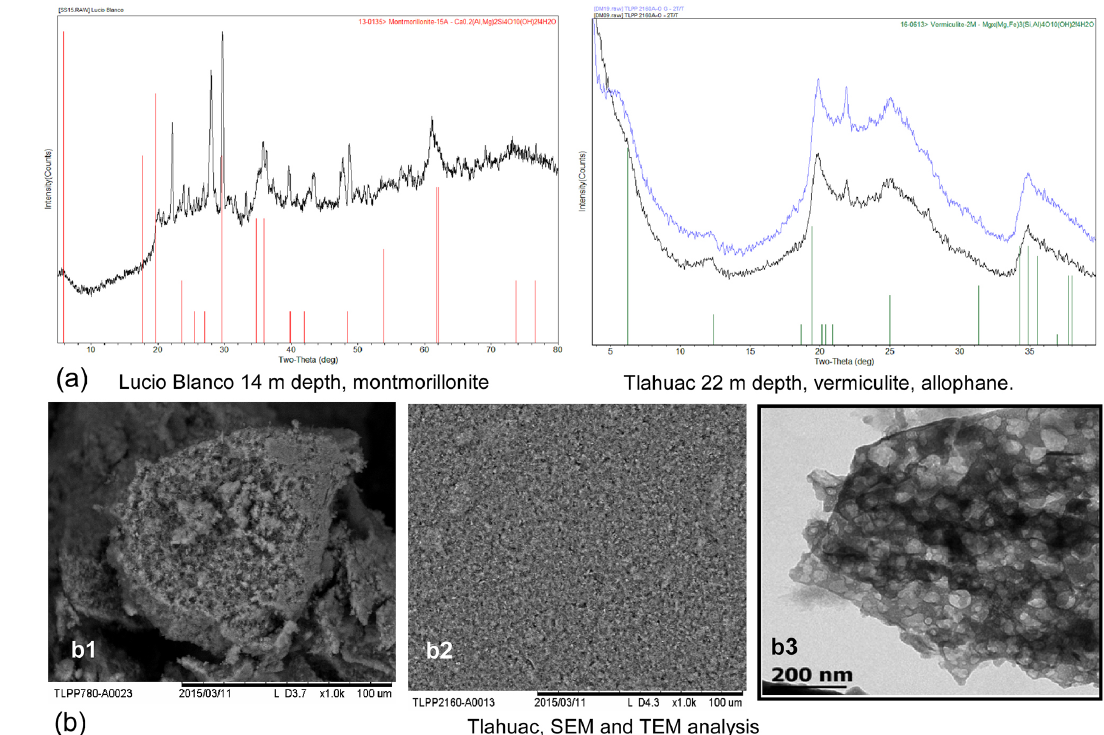
Figure 4. Characterization of the mineralogy and structure of clayey materials. (a) XRD analysis of clays from the Lucio Blanco site (14m depth) showing the montmorillonite signature and from Tlahuac (22m depth) showing the signature of vermiculite and low crystallized material; (b) SEM images from Tláhuac deposits: (b1) , is a silty material at 6m depth; (b2) ; is a low crystallized material at 22m depth and, the (b3) image, taken using an TEM, shows the lack of structure in material similar to